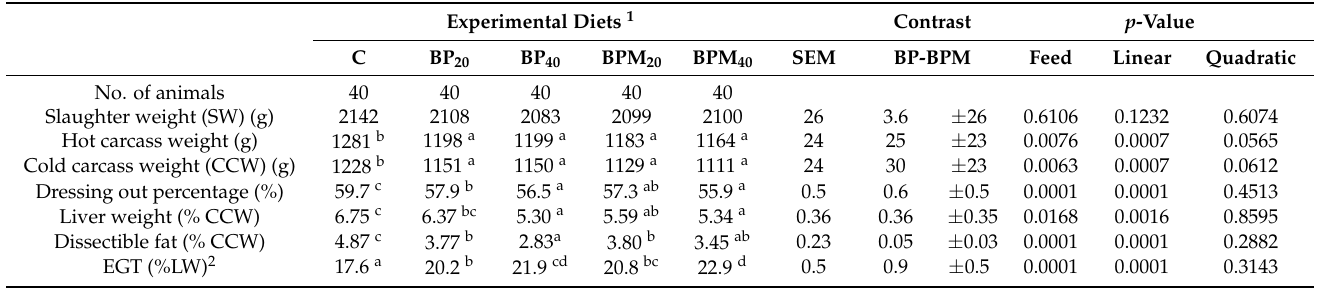
Table 4. Effect of beet pulp inclusion (with or without molasses) on the carcass traits of fattening rabbits at 59 d of